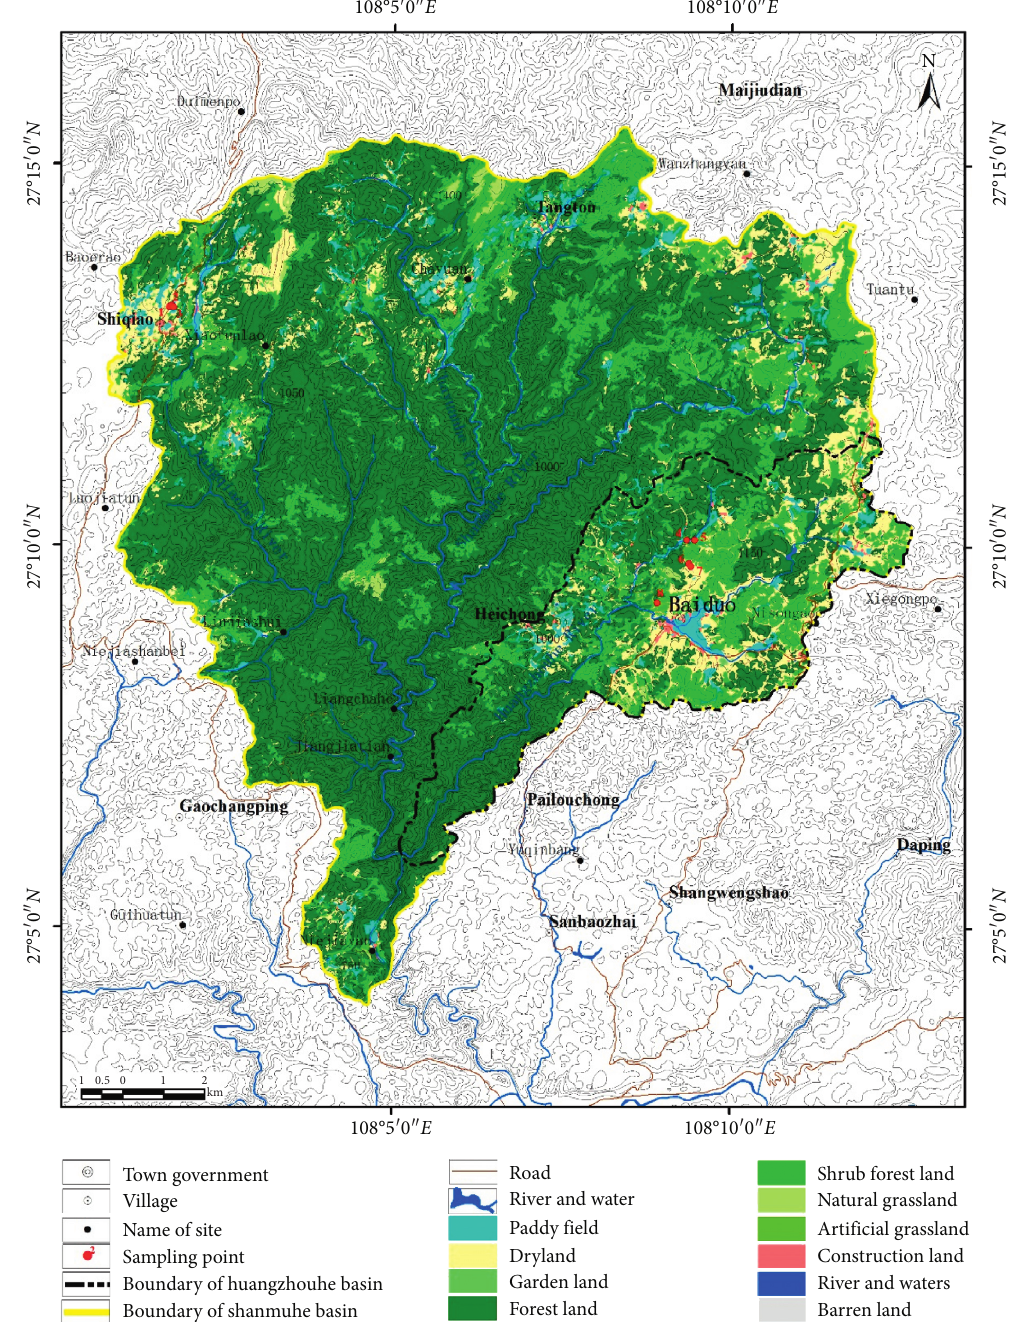
Figure 4: The location of the sampling sites on the land-use